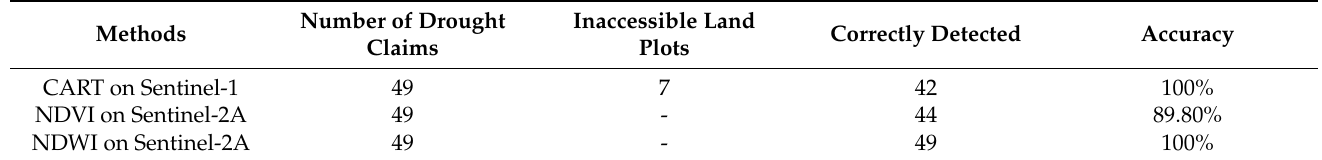
Figure 8. A drought-claimed sample plot obtained using CART classification on Sentinel-1 SAR GRD image. Table 6. Accuracy assessment using verified mobile images of drought detection obtained from CART, NDVI and NDWI for land plots unaffected by cloud on Sentinel-2A